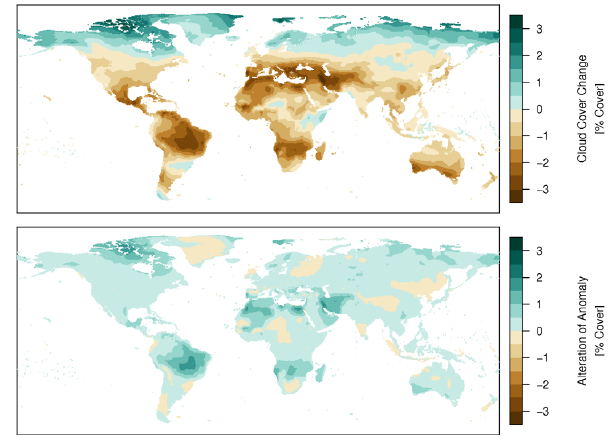
Fig. 4. Upper panel: multi-model mean of the actual applied an- nual mean change in cloudiness in % cloud cover per 1K of 1T glob (Eq. 16). Lower panel: multi-model mean of the alteration of the original anomaly in % cloud cover for 1K of 1T glob (Eq. 17); pos- itive values indicate an augmentation and negative values indicate an attenuation, regardless of the direction of